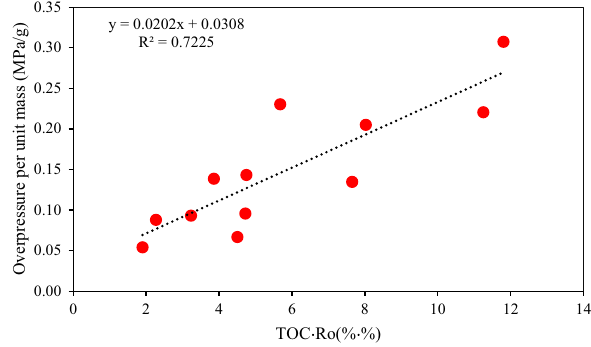
Fig. 1 Relationship between the source rock parameters